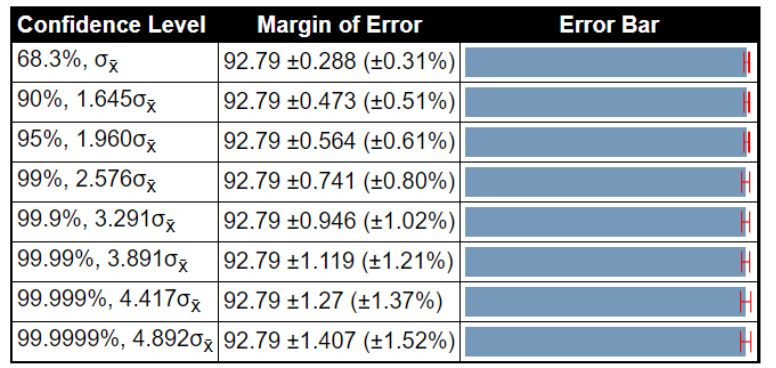
Figure 9. Confidence interval of statistical test for different critical value of t -test (BraTS 2017 dataset).